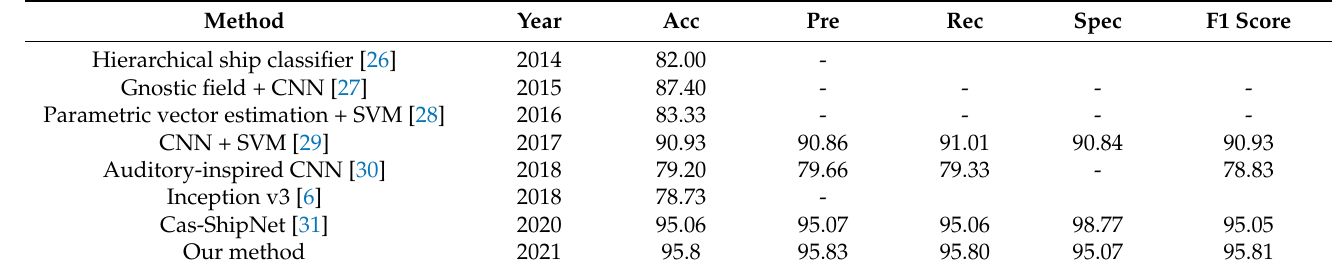
Table 6. Comparison between state-of-the-art